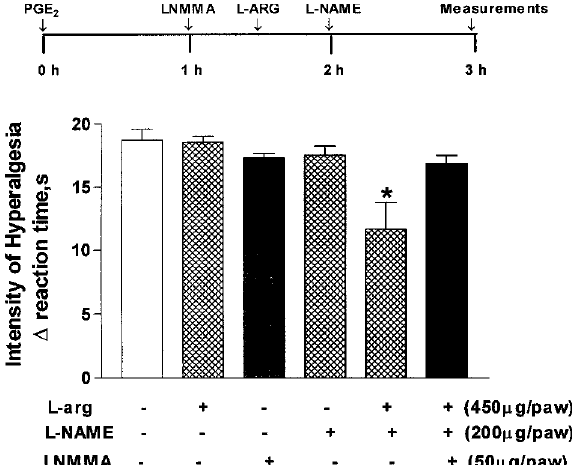
FIG. 4. Antinociceptive synergism between L-NAME and L-arginine. The measurements were made 3h after the intraplantar injections of PGE 2 (100ng/paw). L-NMMA, L-Arginine (L-Arg) and L-NAME were injected into the paw 1, 1.5 and 2h after the PGE 2 challenge, respectively. The bars are the mean ± SEM of five rats/group. The asterisks mean significant differences ( P < 0.05): (a) *in comparison with the control PGE 2 treated either with L-arg, L-NAME, or saline (S); (b) **in comparison with the group which received L-NMMA + L-arg + L-NAME.